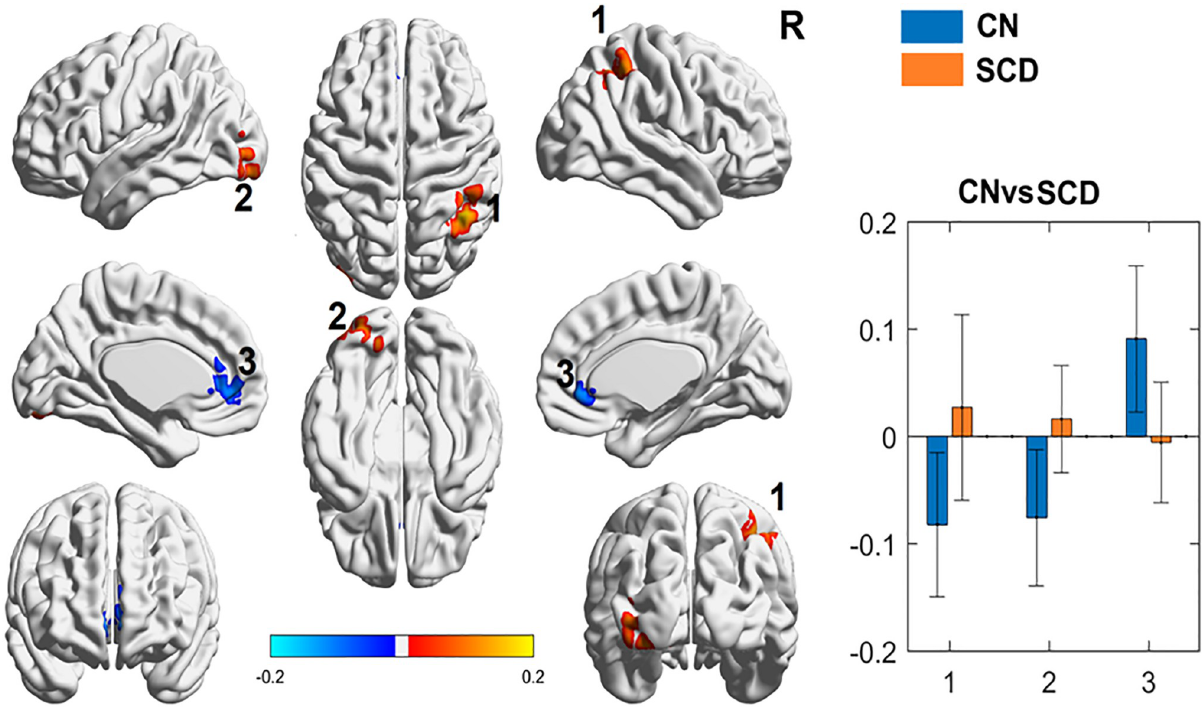
Fig 1. Periaqueductal gray (PAG) seed-based functional connectivity (FC) analyses between patients with SCD (SCD) and controls (CN). Left : Images show the results of the two sample t-test pattern of CN (controls, blue) and SCD (patients with sickle cell disease, orange) PAG FC, respectively. Color is coded based on z-score of the significance. Brain regions with warm color represent the positive connection and cold color represents the autocorrelation with PAG regions. Brain regions are numbered: (1) right inferior and superior parietal lobule, (2) left inferior occipital gyrus (Brodmann area 17 and 18), and (3) left and right anterior cingulate. Right : In comparison to CN (blue), SCD (orange) demonstrated increased connectivity in (1) right inferior and superior parietal lobule, (2) left inferior occipital gyrus (Brodmann area 17 and 18), and decreased connectivity in the (3) left and right anterior cingulate (y-axis = z-score of the significance, x-axis = brain region of interest by number).